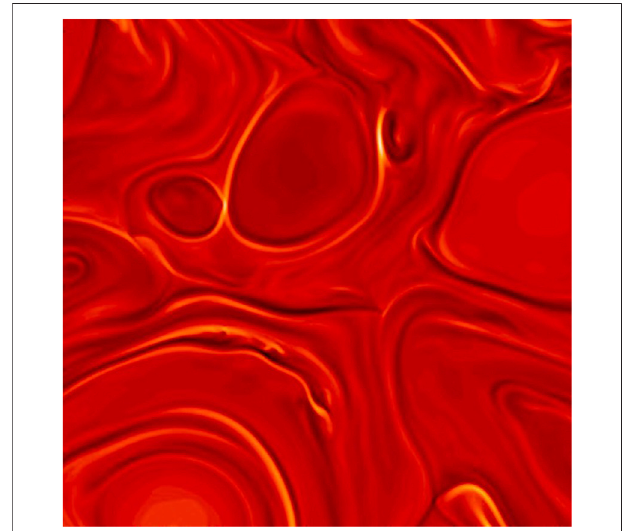
FIGURE 1 | A snapshot of the hybrid-Vlasov – Maxwell numerical simulation showing shaded iso-contours of the out-of-plane electron fl ow. Adapted from Califano et al., this